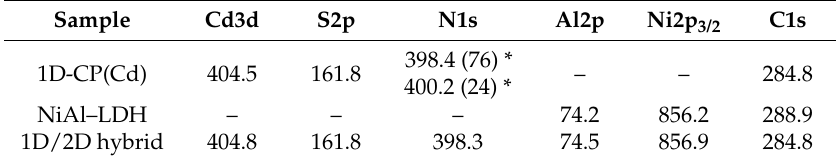
Table 1. Binding energy (eV) of core-levels of 1D-CP(Cd) , NiAl–LDH and 1D/2D hybrid .